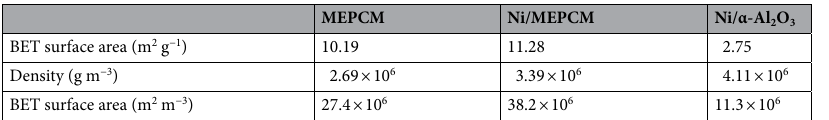
Table 1. BET specific surface areas per mass or volume, and densities of the MEPCM, Ni/MEPCM, and Ni/α-